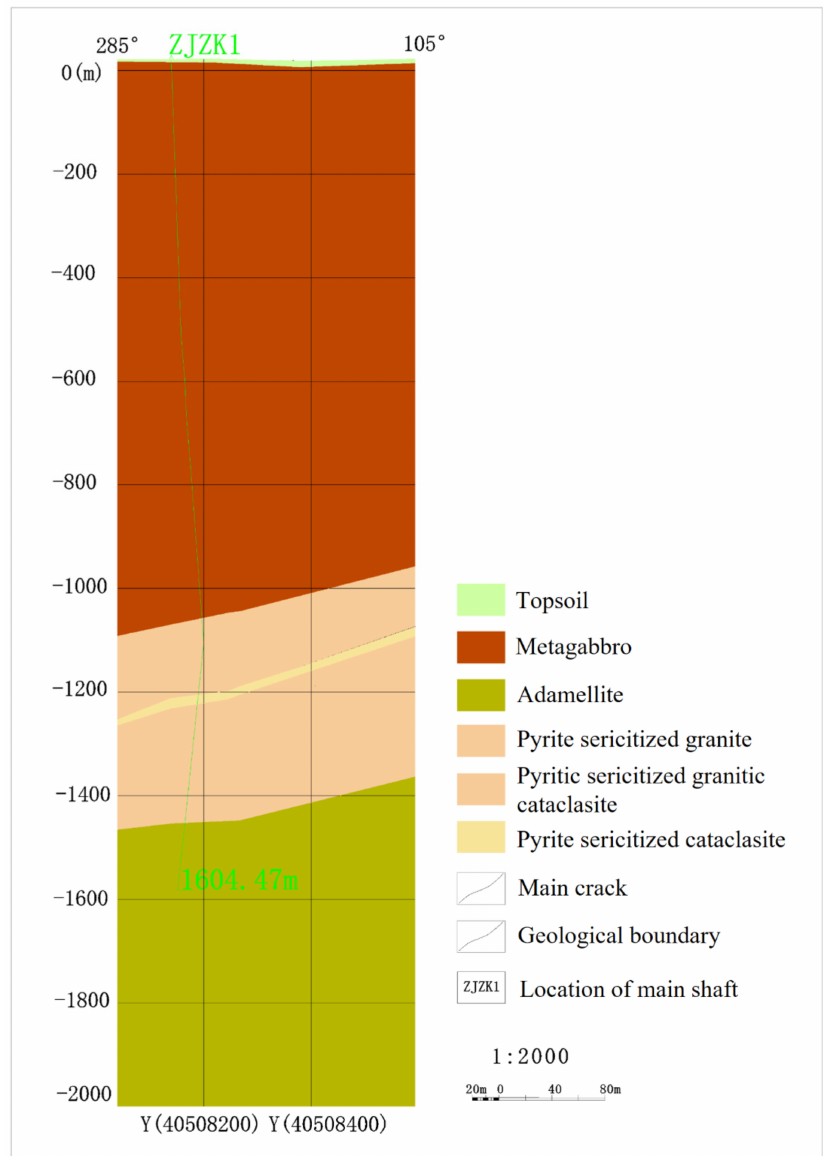
Figure 2. Borehole histogram of